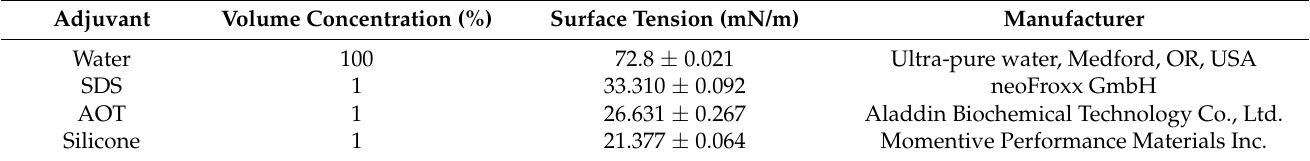
Table 2. Spray solutions mixed with different adjuvants.